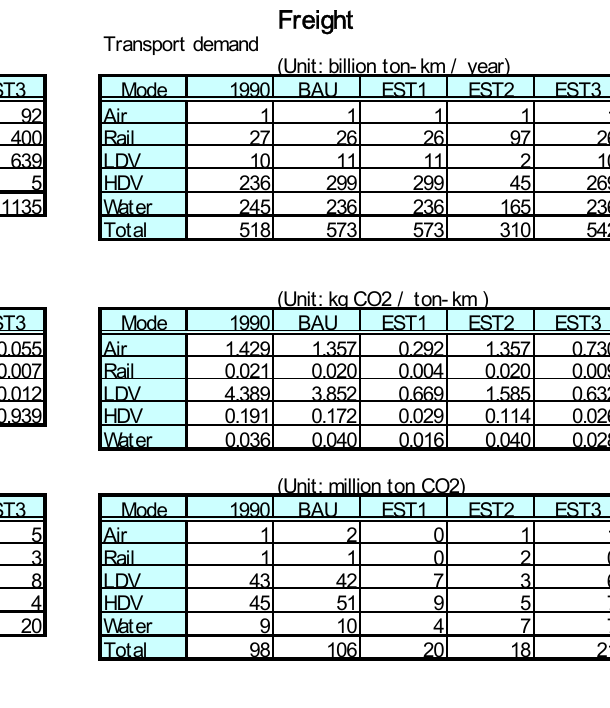
Table Appendix 1 . Comparison of transport demands, emission factors and emission amounts for 1990, BAU and EST